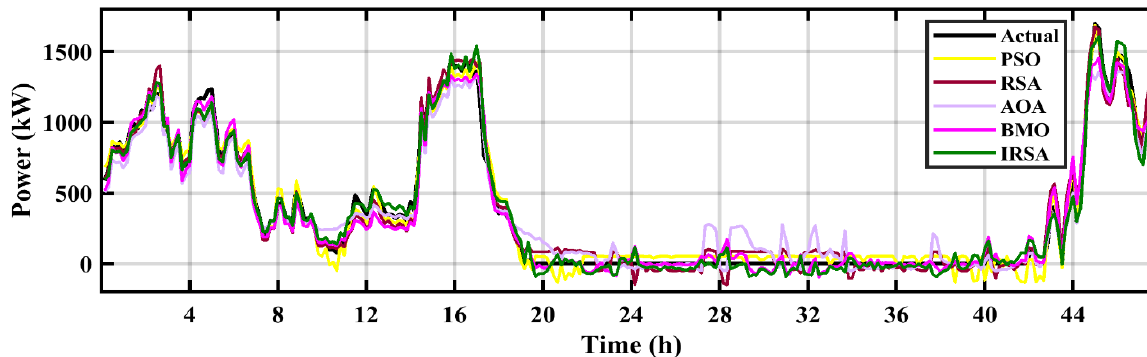
Figure 9. Wind Prediction (Winter).